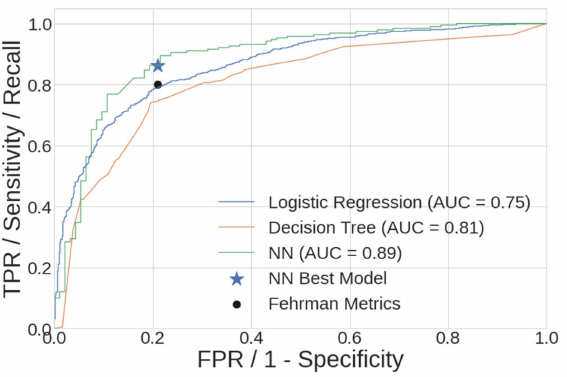
Figure 12. Comparison of ROC curves for the DT, LR and NN models, as measured on the holdout datasets. The sensitivity and specificity of prior work is designated by a round marker [8], and the present work is designated by a star. TPR: true positive rate; FPR: false positive